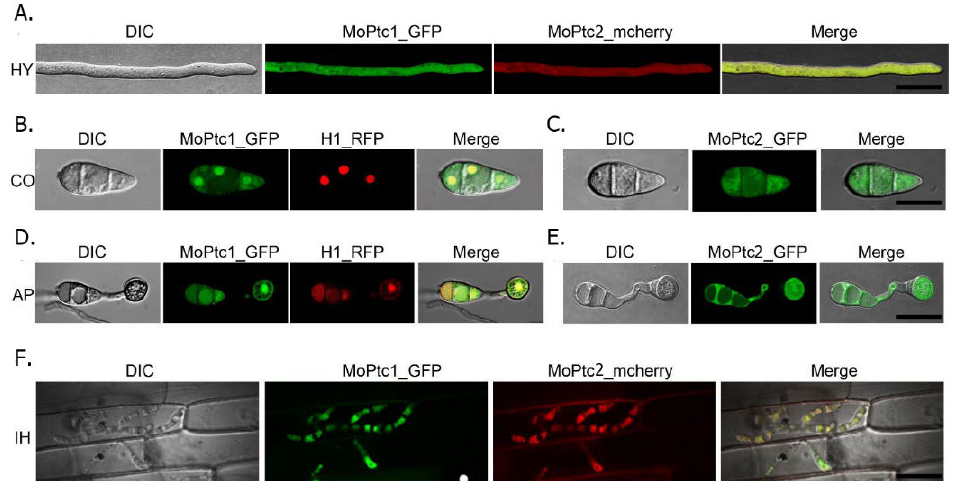
Figure 4. The subcellular localization of MoPtc1 and MoPtc2 protein phosphatases in M. oryzae . ( A ) The colocalization of MoPtc1 and MoPtc2 in hyphal (HY) stages of development ( B ) The localization pattern of MoPtc1 in conidia (CO). ( C ) The localization of MoPtc2 in conidia (CO). ( D , E ) The localization of MoPtc1 and MoPtc2 in appressorium (AP) development. ( F ) The colocalization of MoPtc1 and MoPtc2 in invasive hypha (IH). H1_RFP is the Histone 1 fused with red fluorescence protein. The live cell images were visualized by Nikon Air Laser confocal microscopy (scale bar = 20 µ